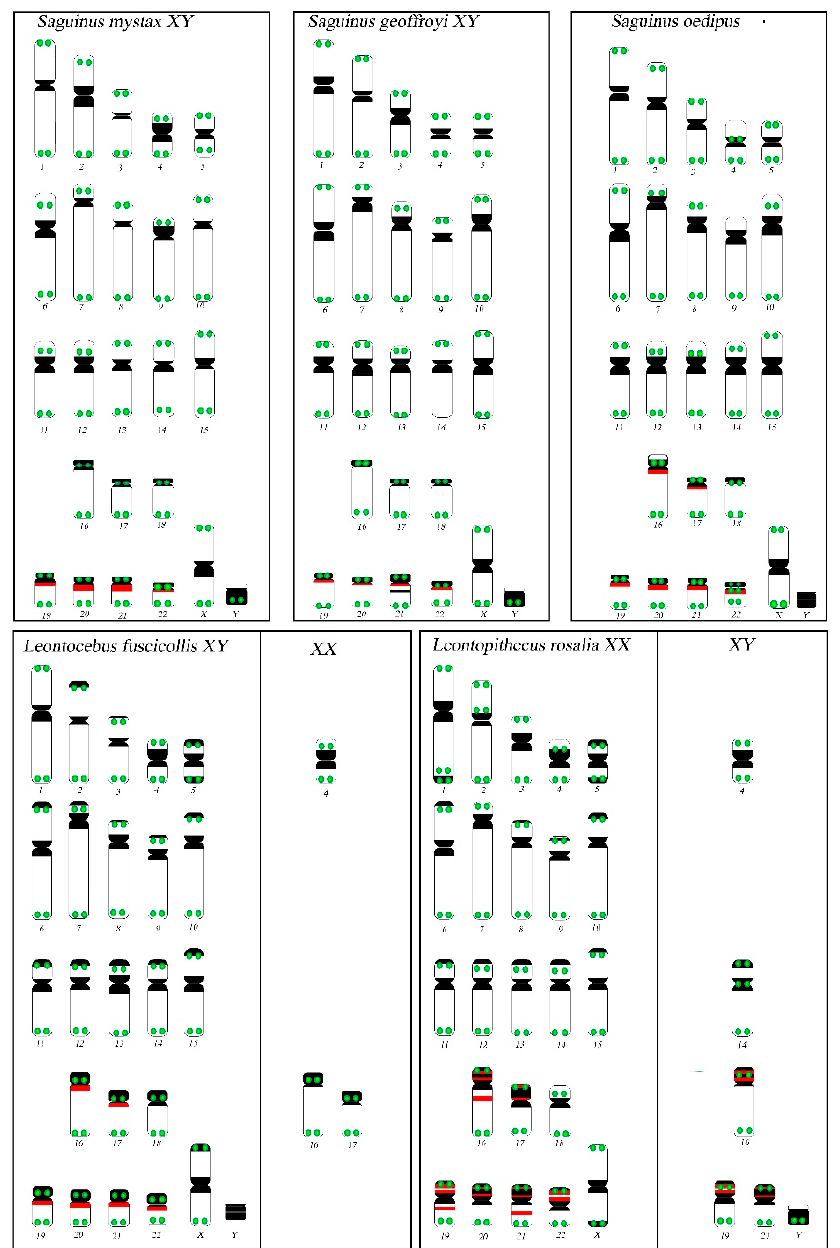
Figure 3. Patterns of the distribution of telomeric repeats, rDNA and heterocromatin in five tamarin species. Dark regions correspond to constitutive heterochromatin blocks. A schematic representation of chromosomes and bands was compiled from this study and others [9,11,29]. Telomeric signals are in green, rDNA probes signals are in red; chromosome variants are reported in the boxes on the